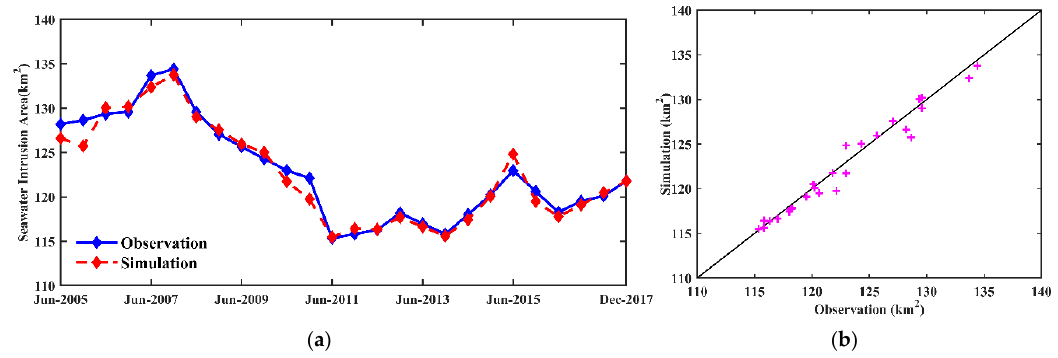
Figure 8. Comparison between observation and simulation of six-monthly SIA using integrated model: ( a ) line plot of results; ( b ) scatter plot of results.